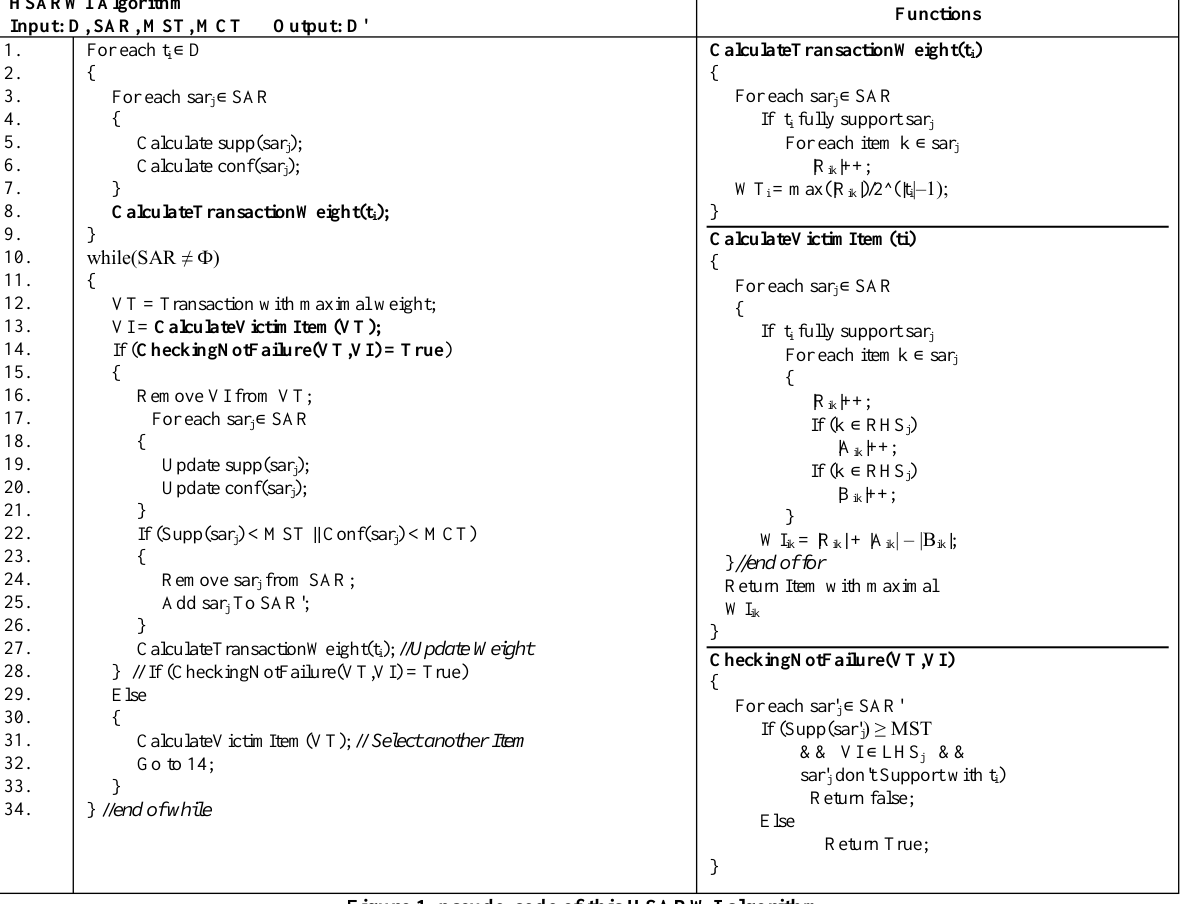
Figure 1. pseudo-code of this HSARWI